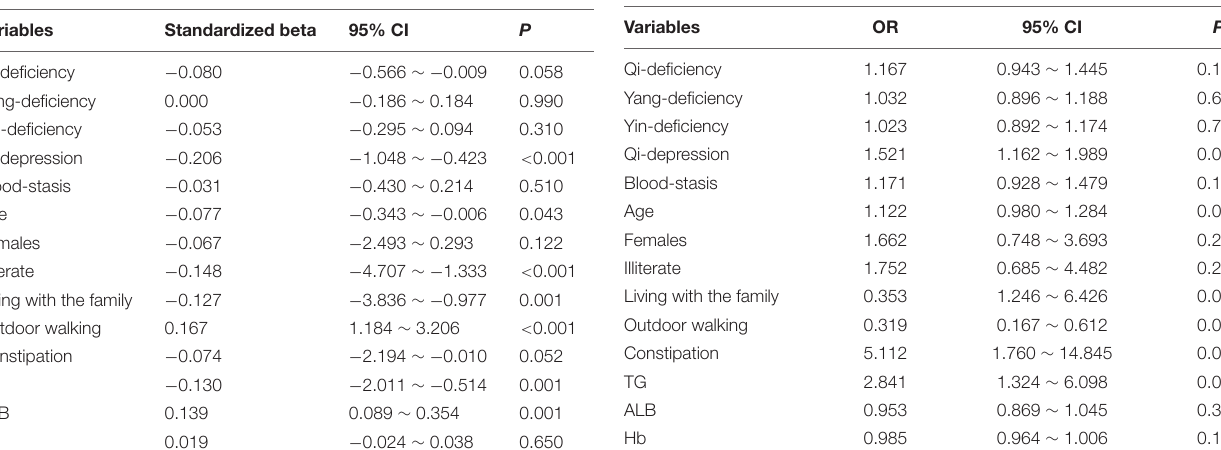
TABLE 2 | Multiple linear regression analysis between Traditional Chinese Medicine (TCM) constitution and Mini-Mental State Examination (MMSE) scales.